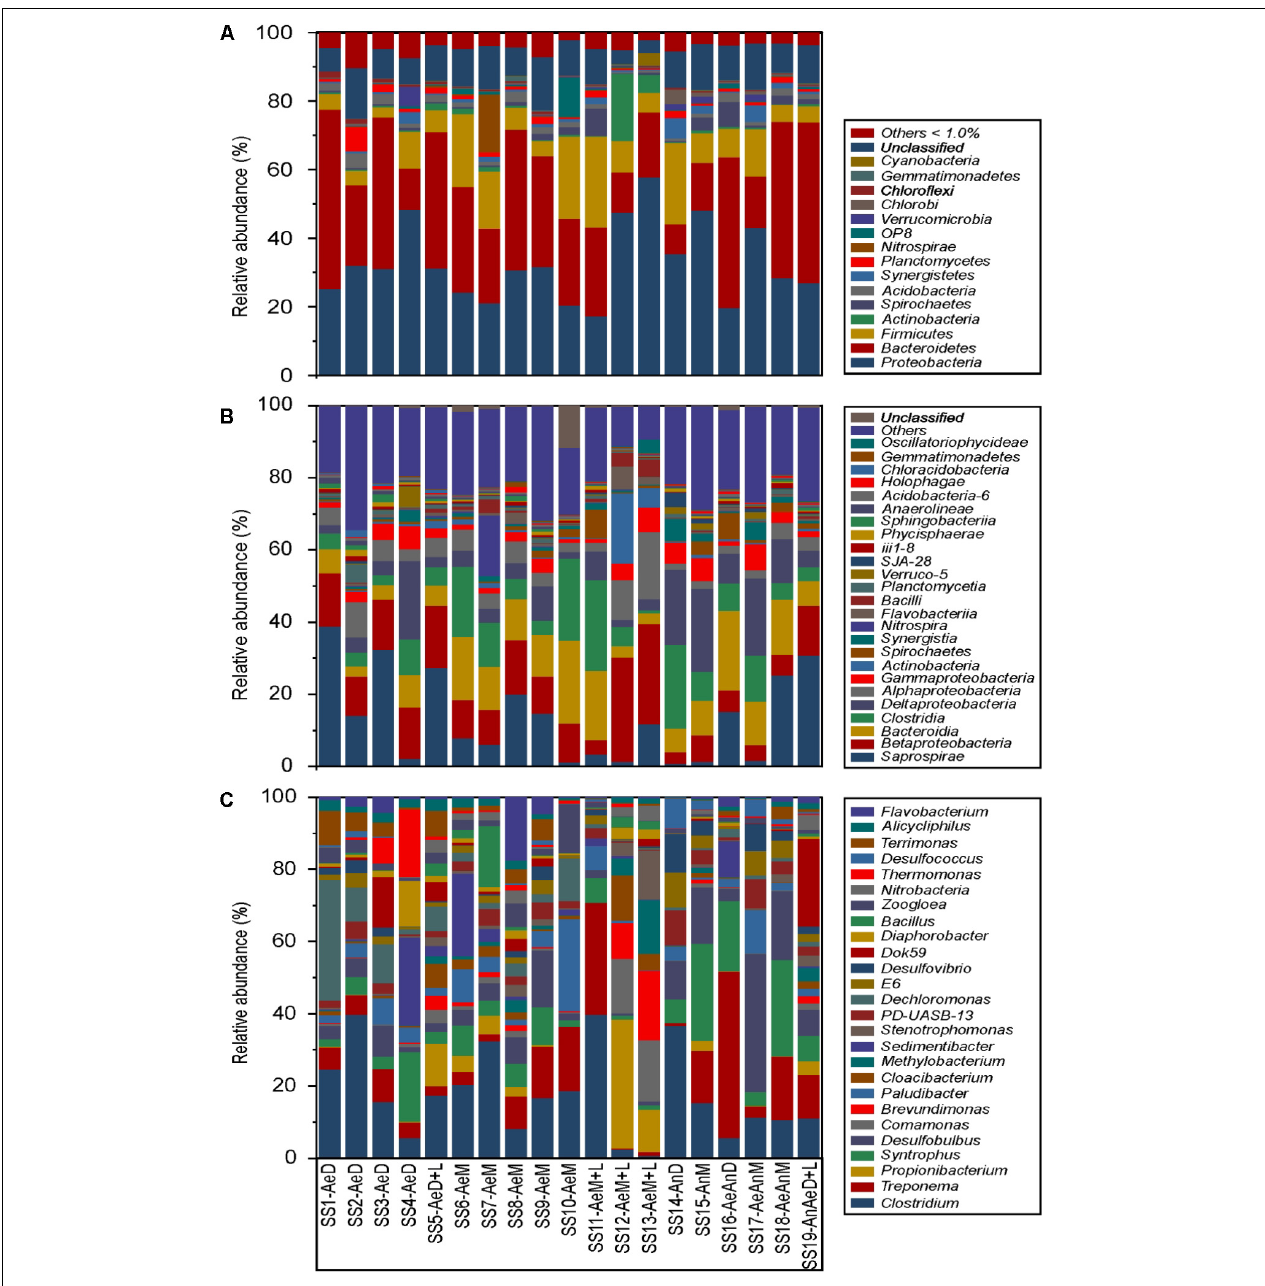
FIGURE 1 | Relative microbial community abundance of 19 sewage sludges from São Paulo State, Brazil. ( A , phyla; B , classes; C , genera; Others, members with relative abundance <